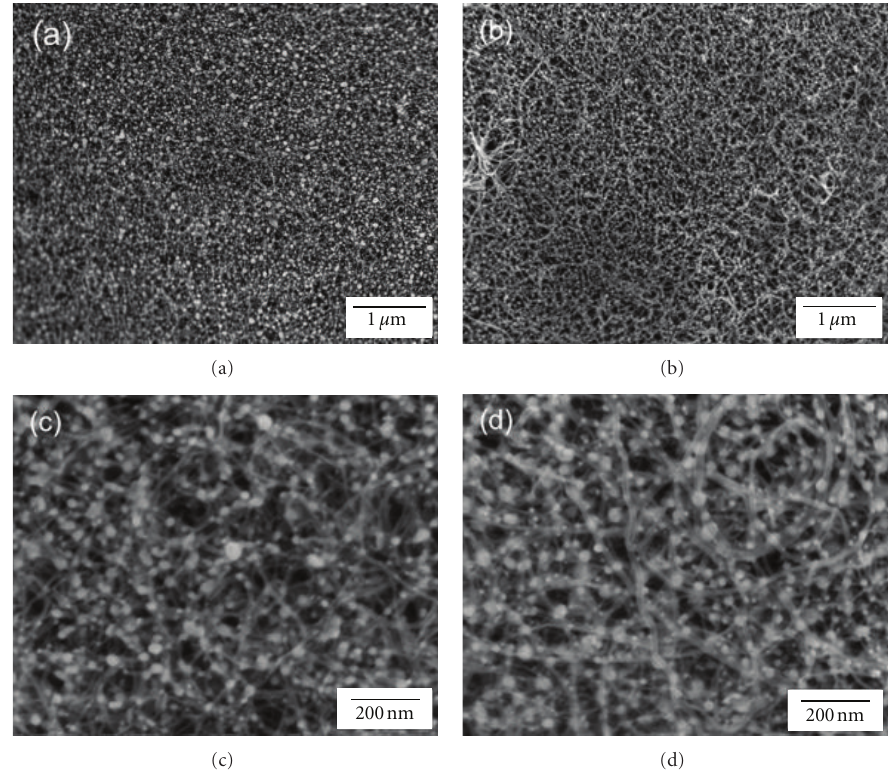
Figure 7: SEM micrographs of Pd/CNT/Foam (a, c) before and (b, d) after the carbon tetrachloride (CT) dechlorination test.